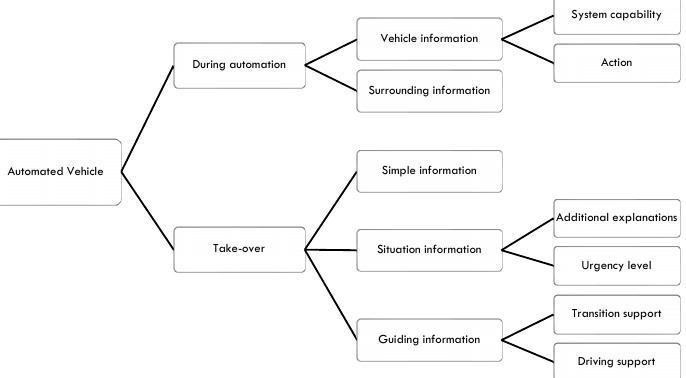
Figure 1. User interface (UI) categorization from an automated vehicle (AV) information perspec- tive .